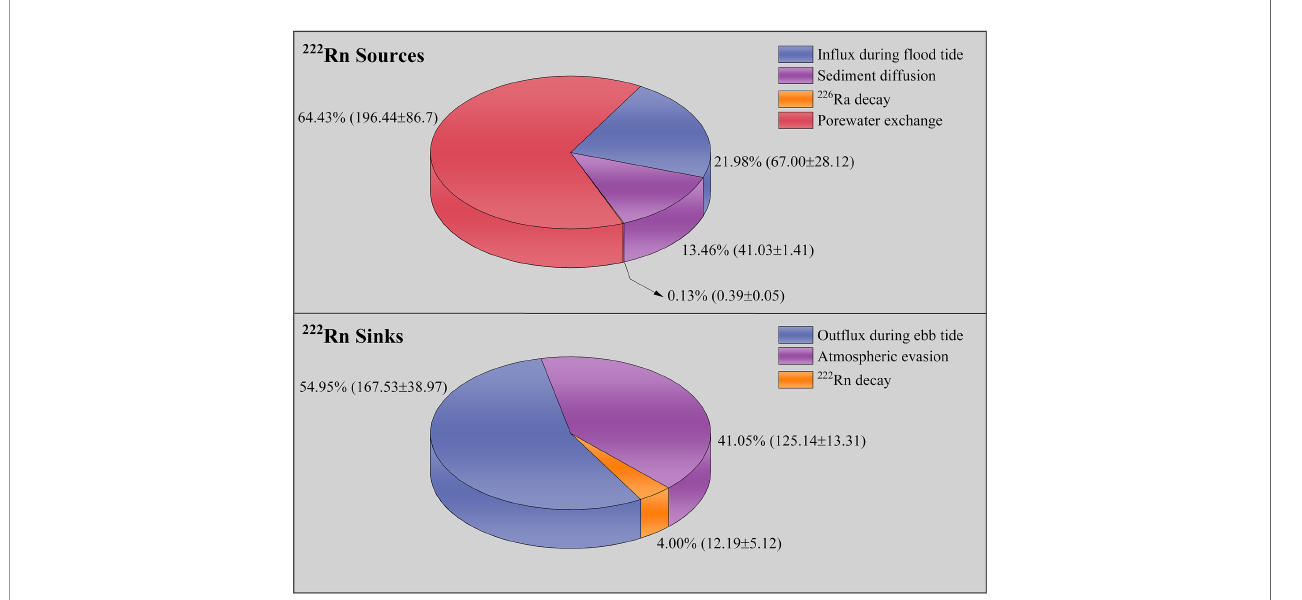
FIGURE 6 | The 222 Rn sources and sinks (Bq m -2 d -1 ) in Andong